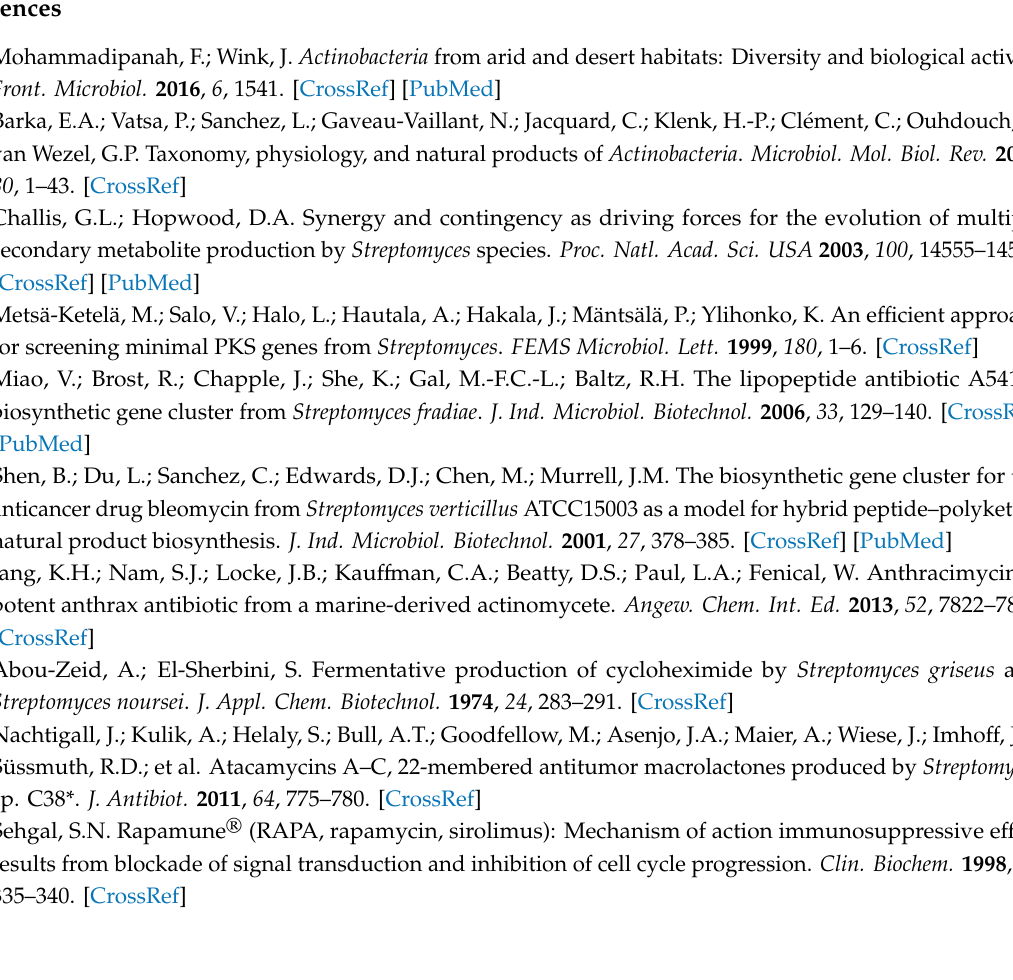
Figure S1: 16S rRNA gene sequence alignment of the Streptomyces strains. Supplementary materials also contains dereplication overview, the individual identification of the molecules, their structures and chemical data, as well as antibiotic activity of the crude